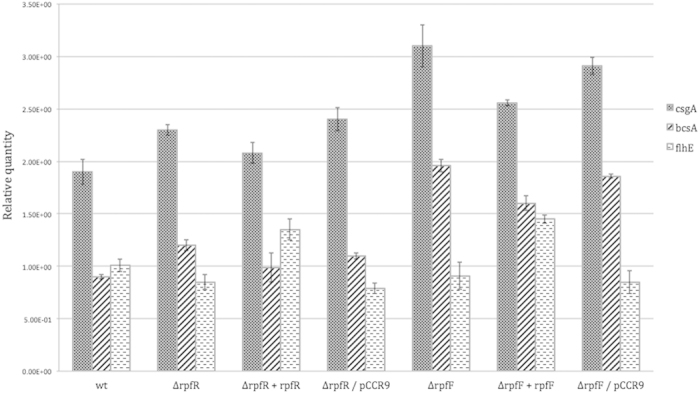
RT-qPCR analysis of csgA, bcsA and flhE gene expression in C. turicensis LMG 23827T (wt), the mutants (ΔrpfF, ΔrpfR), the complemented mutants (ΔrpfF + rpfF, ΔrpfR + rpfR) and the mutants carrying the empty vector (ΔrpfF/pCCR9, ΔrpfR/pCCR9).The respective mRNA levels were normalized to the 16S rRNA reference gene. Error bars indicate SEM, n = 3.